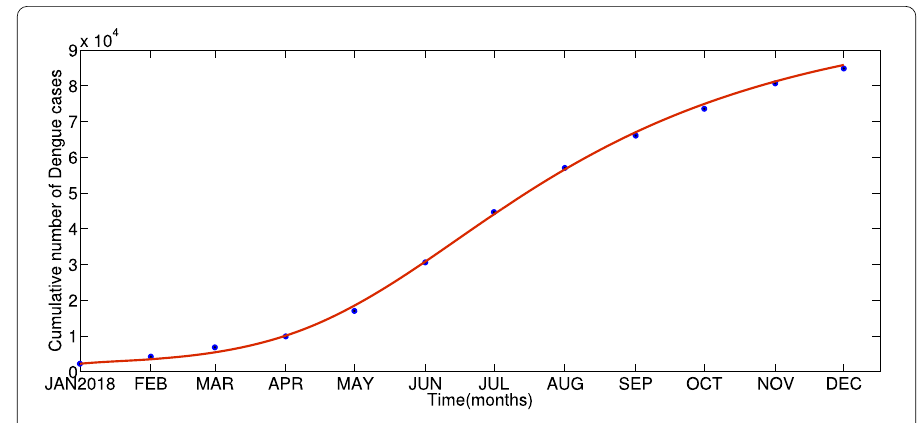
Figure 3 Comparison of the cumulative number of infected number produced by the multi-serotype dengue model and the cumulative number of reported dengue cases in Thailand, 2018